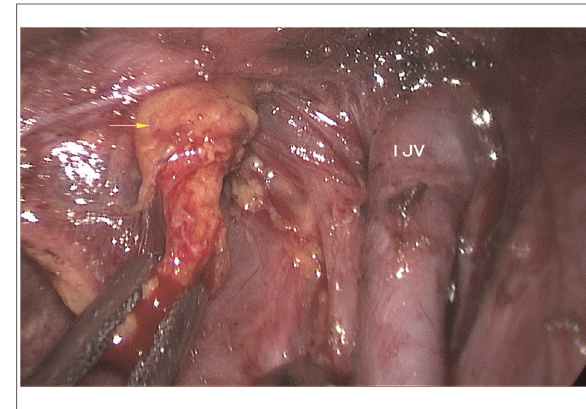
FIGURE 3 The left side residual lymph nodes (yellow arrow). IJV: internal jugular